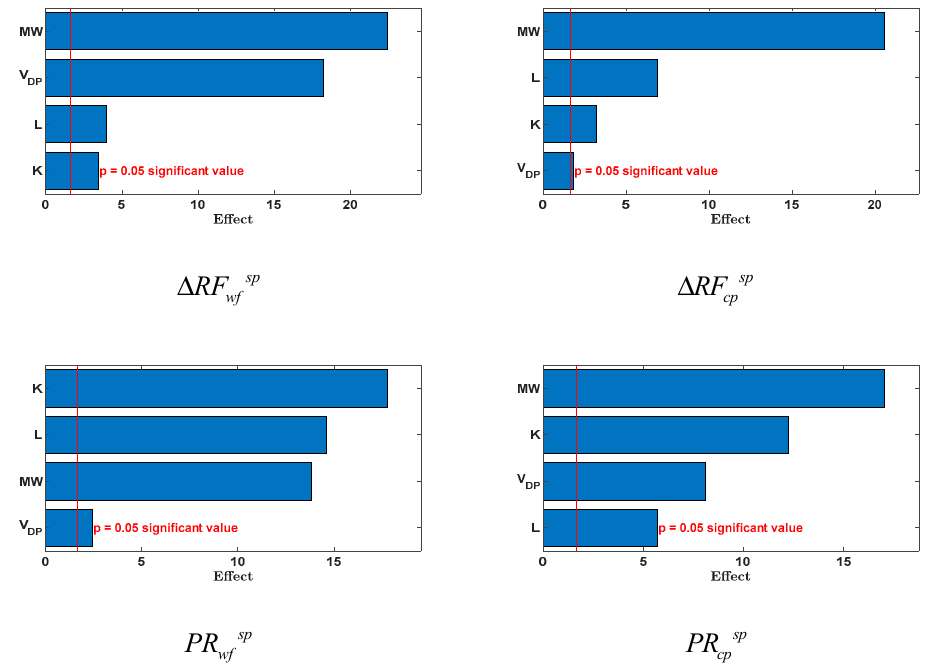
Figure 11. Pareto chart for the selected objective functions using a folded two-level Plackett–Burman design as part of the surrogate modeling workflow. Parameters with an effect less than the red line are considered insignificant, and more than the red line are considered heavy-hitters.